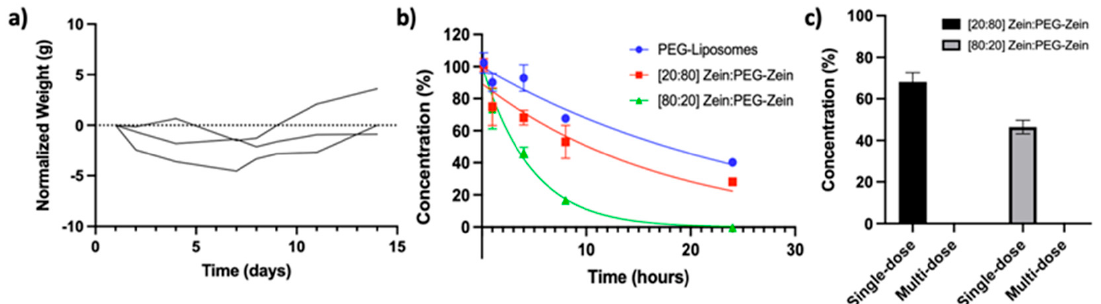
Figure 10. Safety and pharmacokinetic (PK) determination of Zein:PEG-Zein nanoparticles (NP)s: ( a ) two-week time course of weight changes in CD-1 mice dosed with 70 mg/kg of [80:20] Zein:PEG- Zein NPs; ( b ) PK profile of BALB/c mice dosed with 70 mg/kg of an [80:20] or [20:80] Zein:PEG-Zein NP formulation or with PEG-liposomes dosed at approximately 160 mg/kg of lipid; ( c ) concentration of [80:20] or [20:80] Zein:PEG-Zein NP formulations dosed at 70 mg/kg, either as a single exposure or after multiple exposures to the Zein NP formulations (e.g., the fourth and final dose of the multi-dose study).